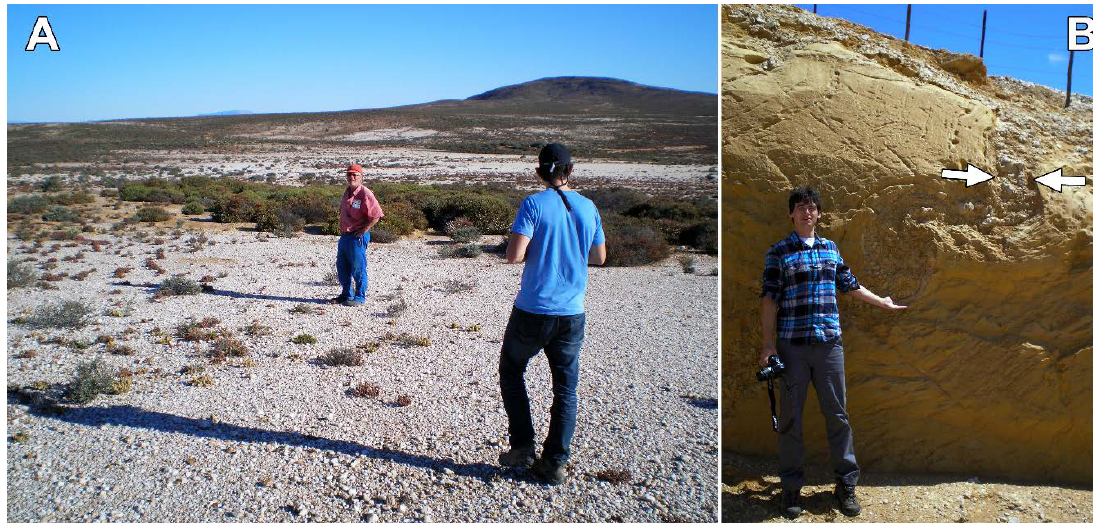
Figure 9. ( A ) Co-author M.T. Hoffman (left) and research assistant M.P. King in a Knersvlakte quartz pavement landscape, 42 km north-northwest of Vanrhynsdorp, Western Cape Province, located 0.5 km west of Highway N7. Note the white pavements on gentle footslopes of the distant hillslope. Coordinate of site: −31.2669° S, 18.5477° E, 257 m elev. ( B ) M.P. King points out a quartz vein (between arrows) in highly-folded, readily-weathered shale. Excavated exposure 25 km north-northwest of Vanrhynsdorp to the west of Highway N7. Coordinates: −31.3993° S, 18.6580° E, 124 m elev.